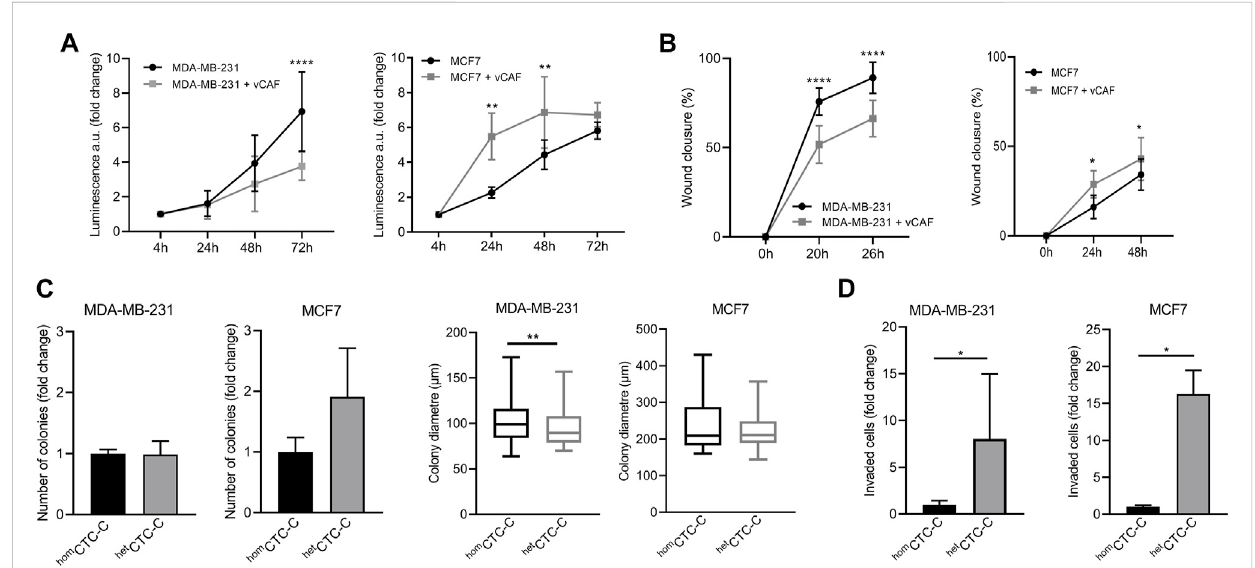
FIGURE 1 EvaluationoftheeffectofvCAF fi broblastsonBCcelllinesby invitro functionalassays. (A) ProliferationofMDA-MB-231( n =3)andMCF7( n =4)cells in presence of vCAF along 72 h. Data are expressed as the fold change of proliferation relative to time 4 h; (B) Wound healing capacity of MDA-MB-231 ( n = 5) and MCF7 ( n = 2) cells in presence or absence of vCAF; (C) Number of colonies generated by hom CTC-C and het CTC-C from MDA-MB-231 ( n = 3) and MCF7 ( n = 3) cells in soft agar colony formation assays represented as the fold change of het CTC-C over hom CTC-C, and average colony diameter; (D) Invasionof hom CTC-C and het CTC-C derivedfrom MDA-MB-231( n =3) and MCF7 ( n =2)cell lines. Data are expressedasthefold change of migrated cells relative to the migration observed in the hom CTC-C population. * p < 0.05, ** p < 0.01, **** p <